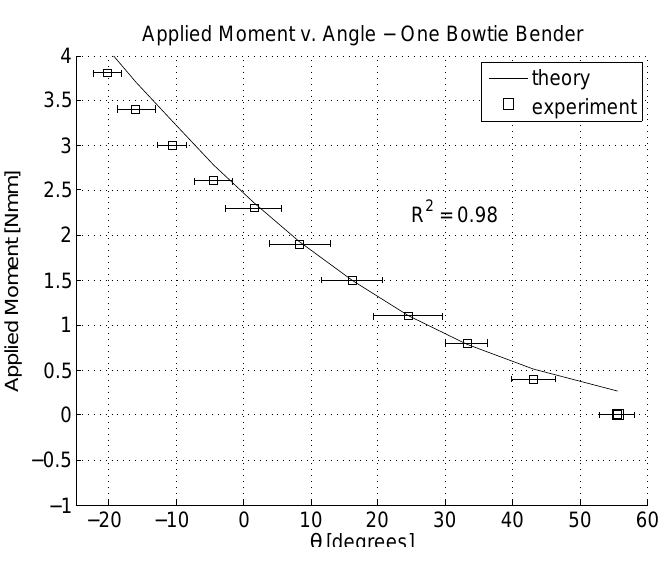
Figure 15. Model fit to data for a single bowtie